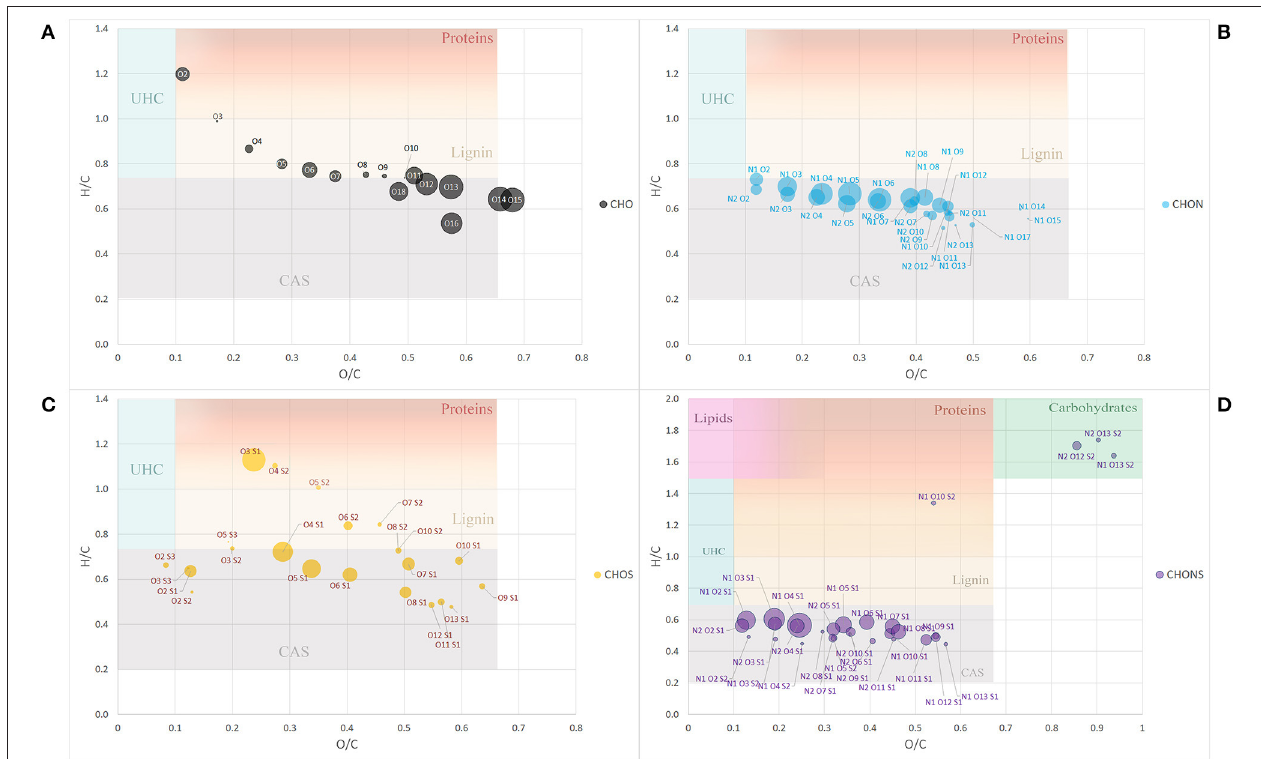
FIGURE 2 | Van Krevelen diagram of class group molecules arranged by the same heteroatoms number. CHO (A) , CHON (B) , CHOS (C) , and CHONS (D) . Size of the bubbles is a measure of their relative abundance. Area identified by H/C and O/C ratios and belonging to different type of organic compounds (proteins, lignins, catbohydrates, lipids, CAS, and UHC) have different background color. Fading colors indicate overlapping of different